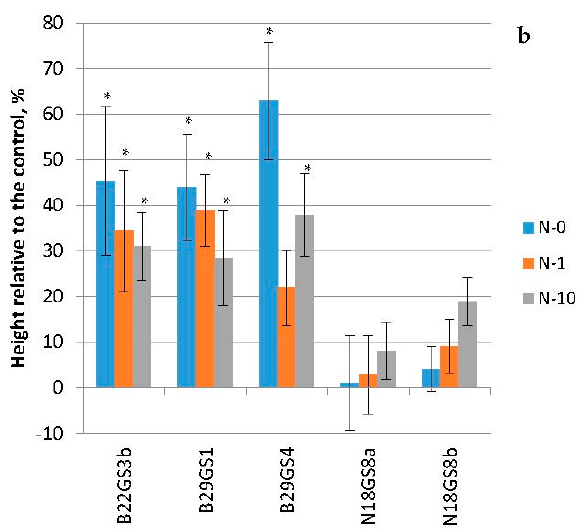
Figure 2. Effect of glutamine synthetase (GS) gene expression and nitrogen fertilization on the growth of transgenic B. pubescens ( a ) and B. pendula ( b ) plants. Asterisks over single bars indicates that